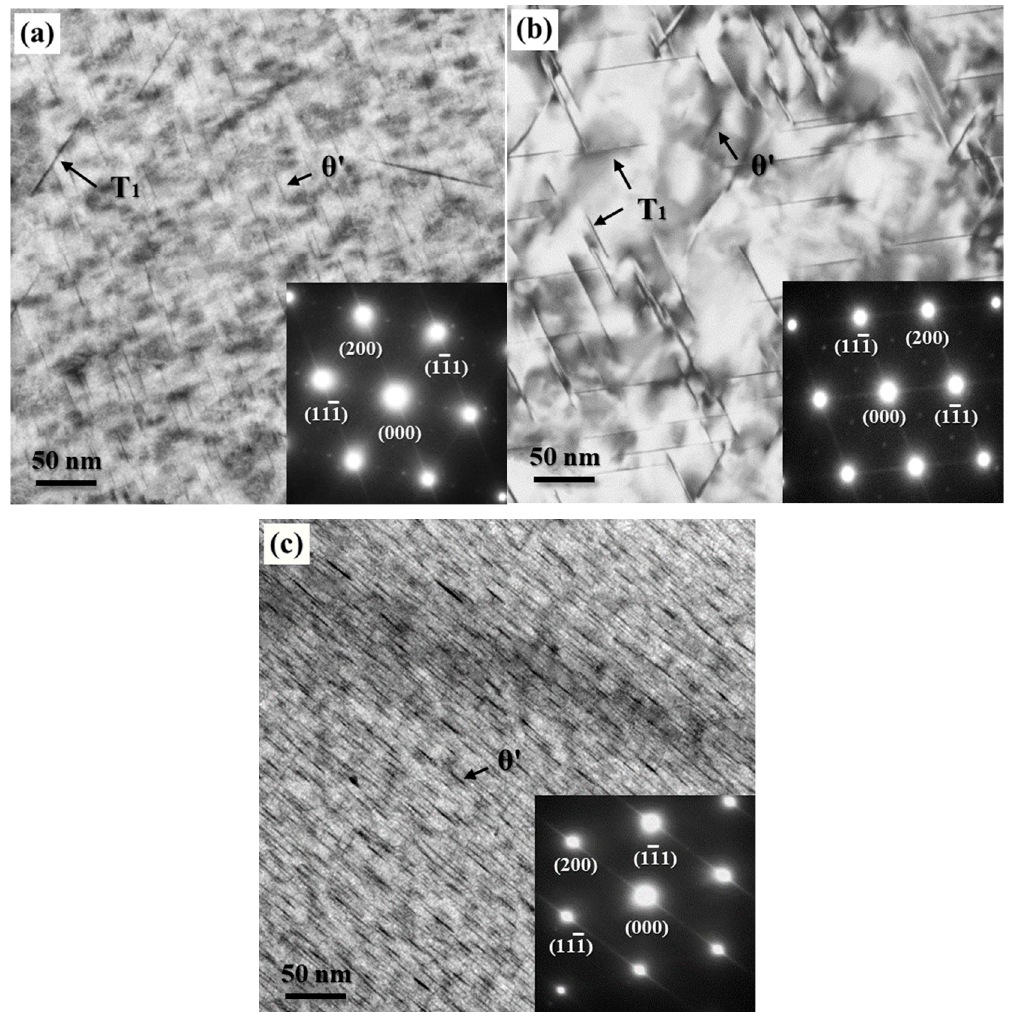
Figure 6. TEM images and SAED spots along [110] Al zone axis of AA2195 specimens: ( a ) creep aged with non-pre-stretching; ( b ) creep aged with pre-stretching 2%; and ( c ) artificially aged with non-pre-stretching.